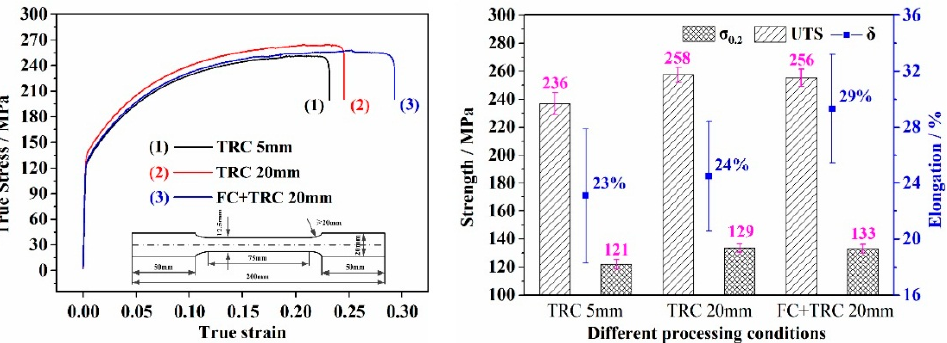
Figure 9. Microstructure and mechanical properties of strips of traditional TRC and FC-TRC conditions. ( a ) Strength of three strips and ( b ) elongation of three strips.